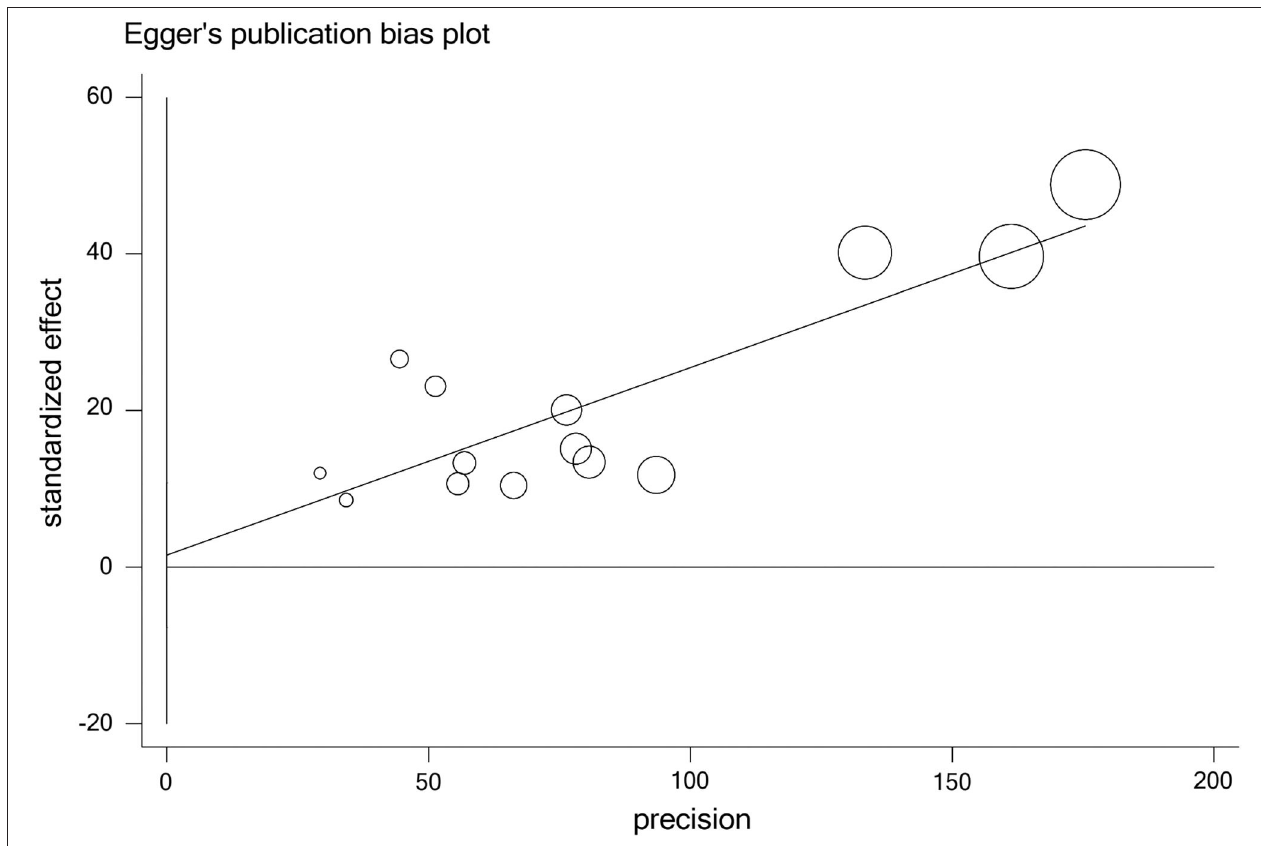
FIGURE 4 | Bubble plots of publication